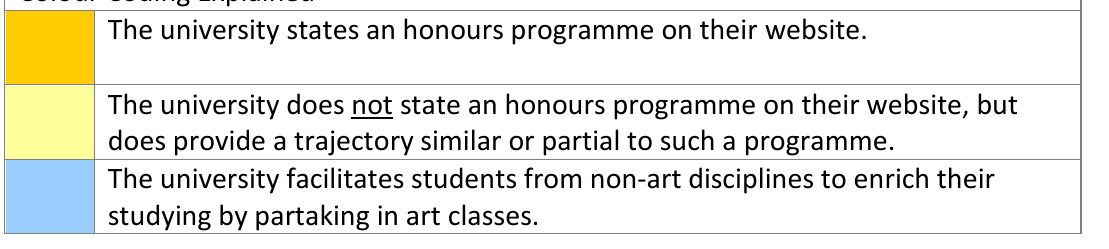
Table 1: List of Universities Colour Coding